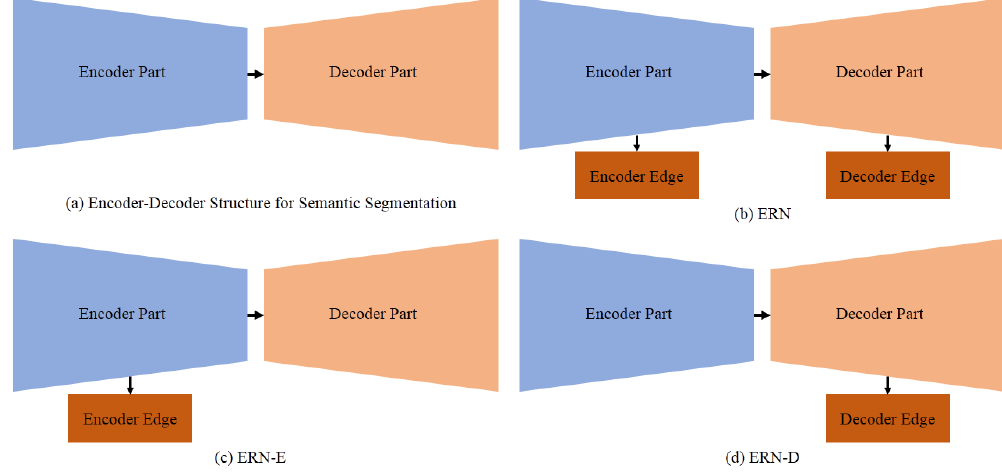
Figure 11. Variations of ERN–ERN-E and ERN-D–with different edge loss reinforced structures.